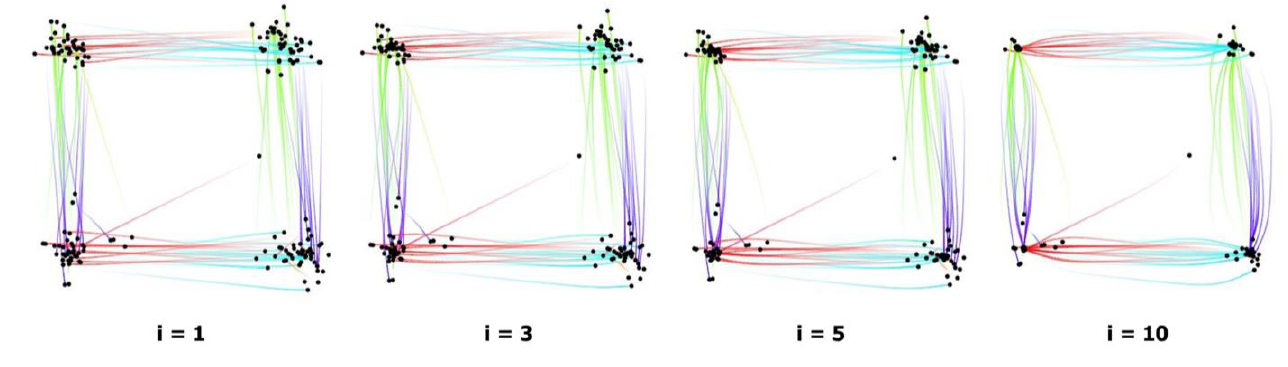
Figure 2. Clustering of fixations using the mean-shift algorithm (i =